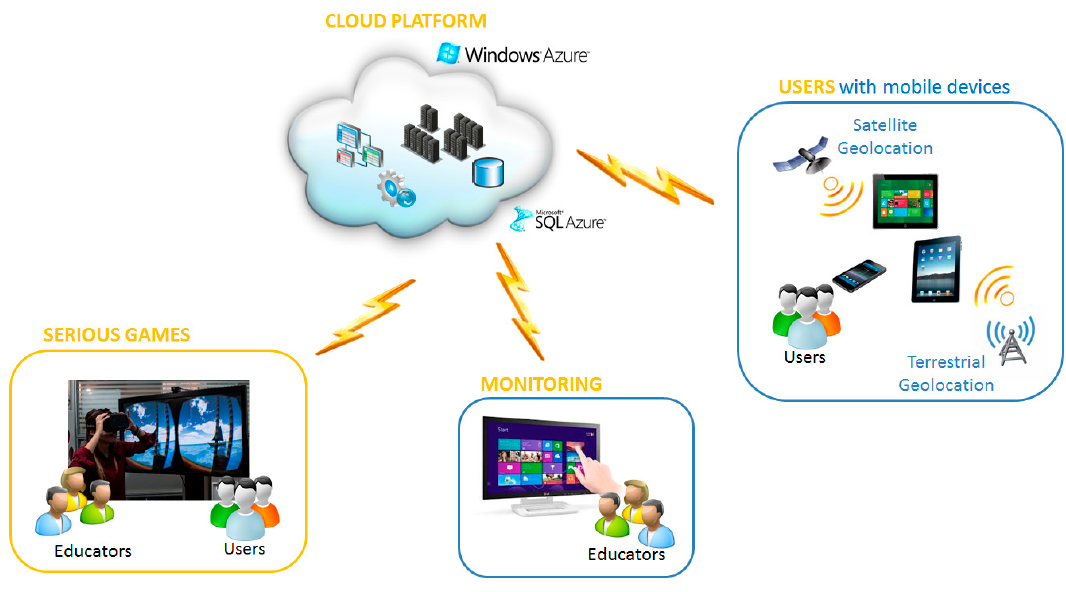
Figure 1. Smart Angel main